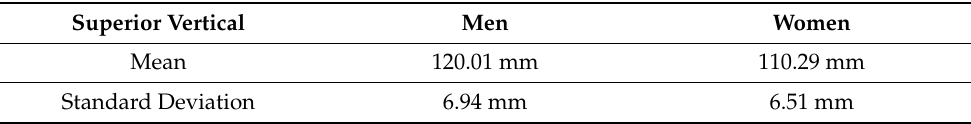
Table 3. Results obtained from the analysis of the sample employing the Vertical Ceph 3D method for the total vertical dimensions (T).